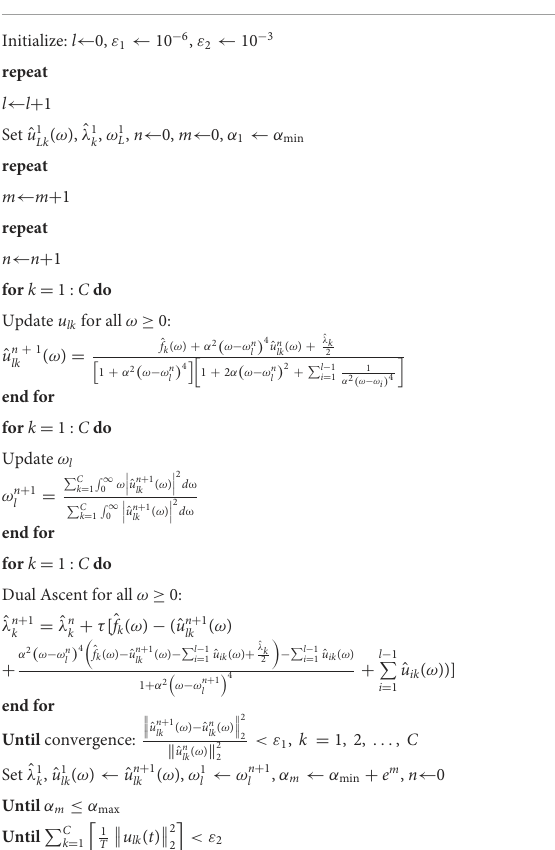
TABLE 2 The complete algorithm of multivariate SVMD. The algorithm of